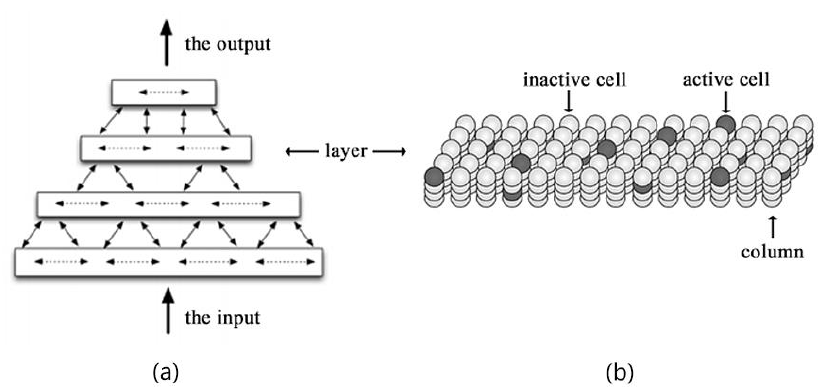
Figure 1. The structure of the HTM model. ( a ) The hierarchy structure of HTM; ( b ) the neuron cells in a layer of columns.